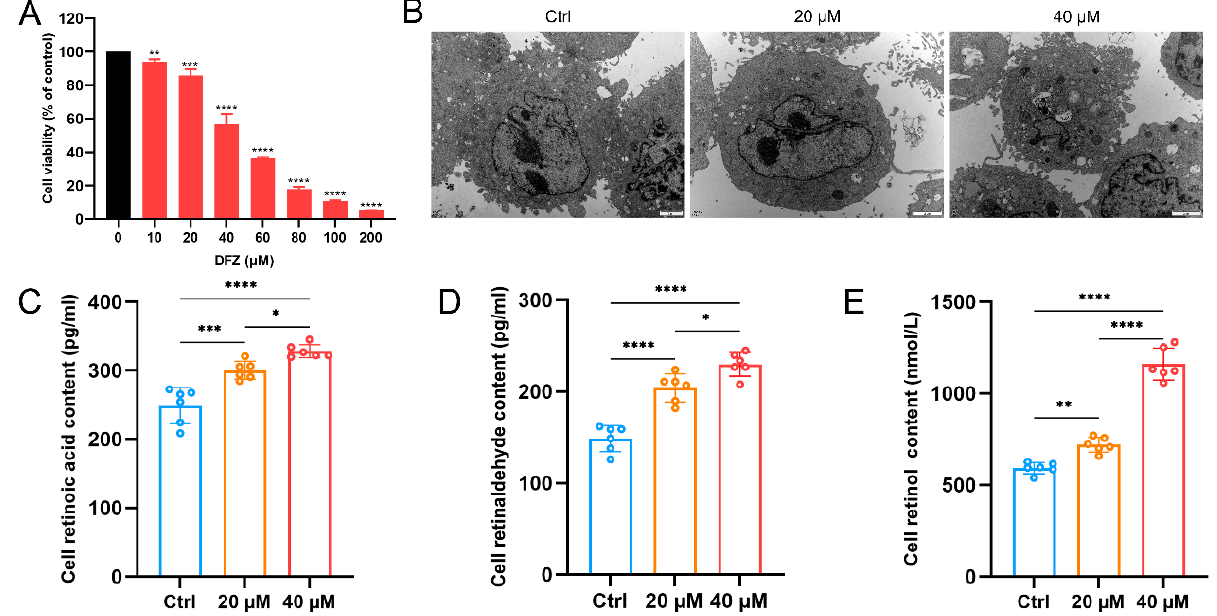
Figure 5. Toxic effects of DFZ on GC-2 cells. ( A ) Cell viability assay of GC-2 cell after exposure to different concentrations of DFZ for 24 h. ( B ) Altered cellular ultrastructure observed by transmission electron microscopy (the scale bar represents 2 µm). ( C ) RA, ( D ) ROL, and ( E ) RE concentrations in GC-2 cells in different groups. * p < 0.05, ** p < 0.01, *** p < 0.001, **** p < 0.0001 versus the control group.